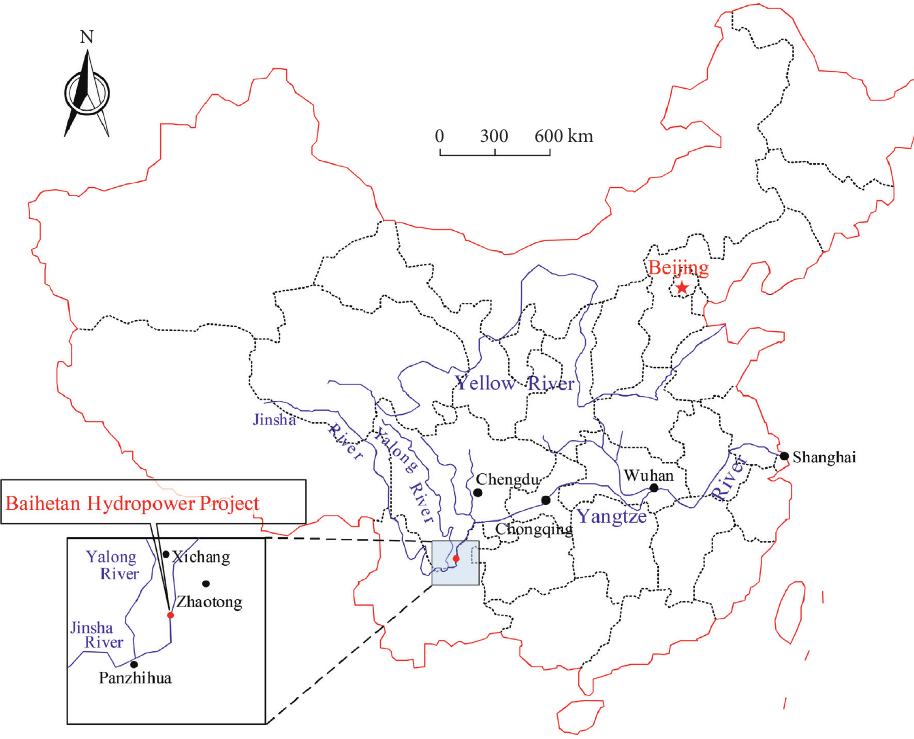
Figure 1: Geographical location of the Baihetan hydropower station [17].